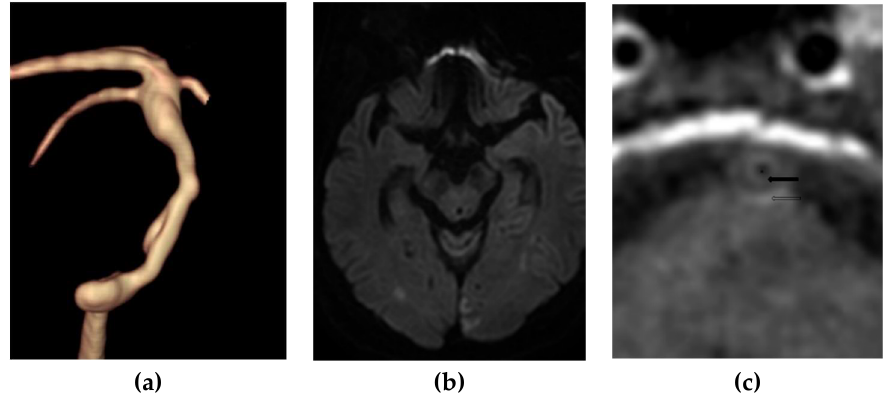
Figure 1. A 78-year-old man with embolic infarction of both occipital lobes. ( a ) Volume rendering imaging using Time-of-Flight MR angiography showed a diffuse atherosclerotic narrowing of the basilar artery. The maximal wall thickness is 3.8 mm and the stenosis degree is 67%. ( b ) Diffusion-weighted imaging showed diffusion restriction in both occipital lobes. ( c ) Contrast-enhanced T1-weighted imaging showed a layered finding between an enhanced fibrous cap (arrow) and adventitia (open arrow) and an intervening nonenhanced lipid-rich necrotic core. * represents the lumen.